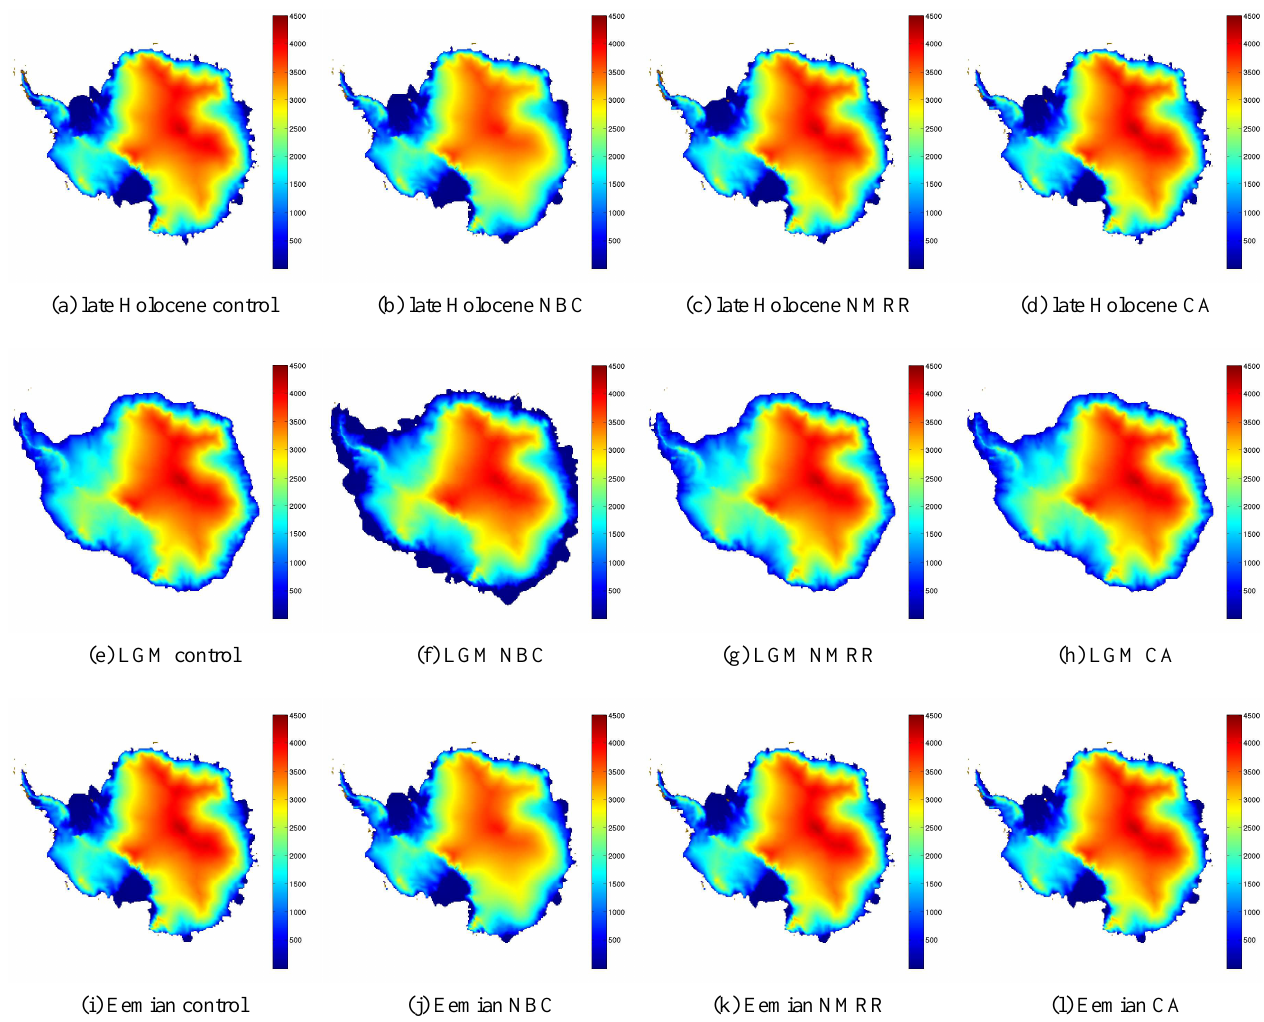
Fig. 7: AIS surface ice elevation (m) from control and perturbed physics experiments. NBC=non-bias-corrected, NMRR=non-meltwater-retention or refreezing, CA=constant albedo.